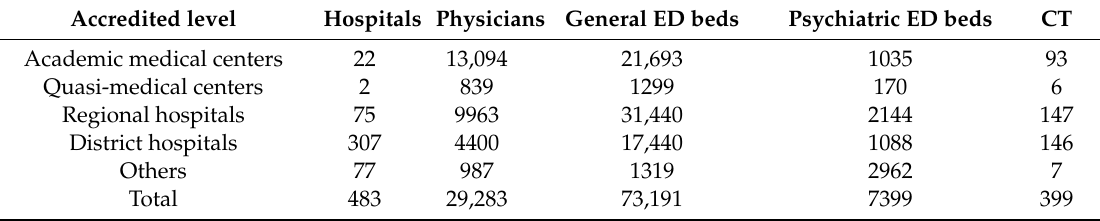
Table 3. The capability of hospitals according to accredited levels by the end of 2017. Accredited level Hospitals Physicians General ED beds Psychiatric ED beds CT Academic medical